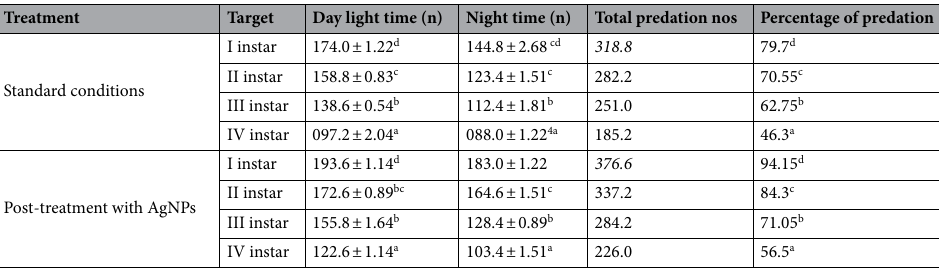
Table 4. Predatory efficiency on mosquito A. stephensi by the teleost fish Gambusia affinis . Predation rates are represented by means ± SD of four replicates (1 fish vs 200 mosquitoes per replicate). Control was clean water without predators within each column, means followed by the same letter are not. Significantly different (P < 0.05).